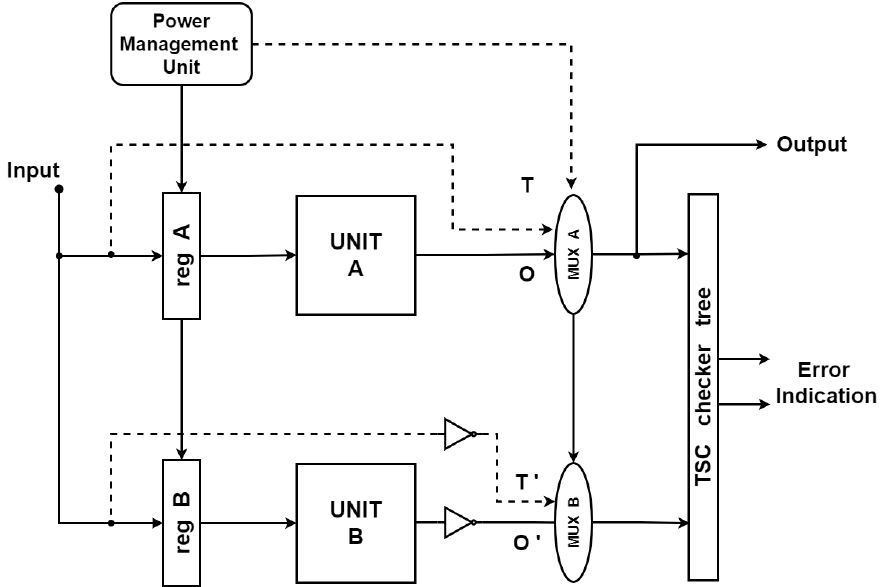
Figure 5. The proposed architecture with by-pass and input re-use